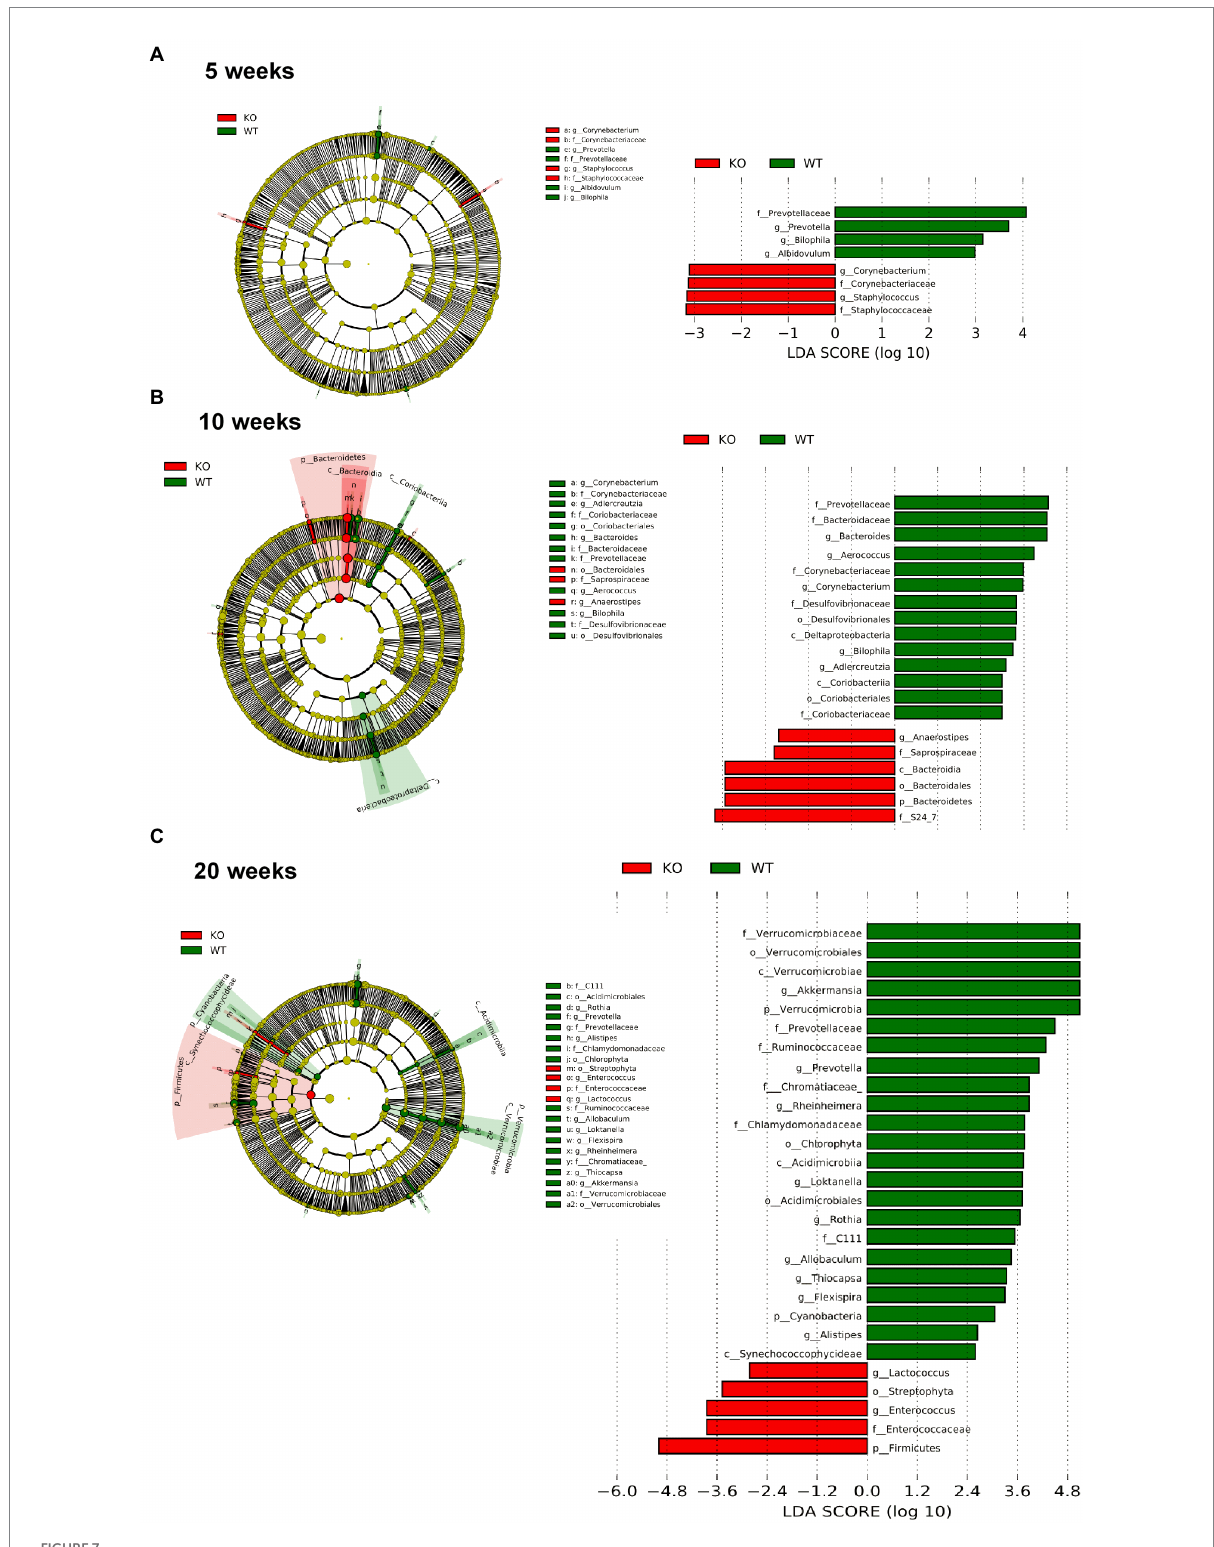
FIGURE 7 Comparison of the differences in the composition of the microbiota of C57Bl/6 wild type (WT) and IL-10 deficient mice (IL-10 − / − ) IL-10 −/− from fecal samples with linear discriminant analysis effect size (LEfSe) analysis at ages 5 (A) , 10 (B) and 20 weeks (C) . Significant differences are considered from 2.0 on the logarithmic scale, both positive and negative. The cladogram indicates the importance of the changes in the bacterial composition for the rest of the populations of the